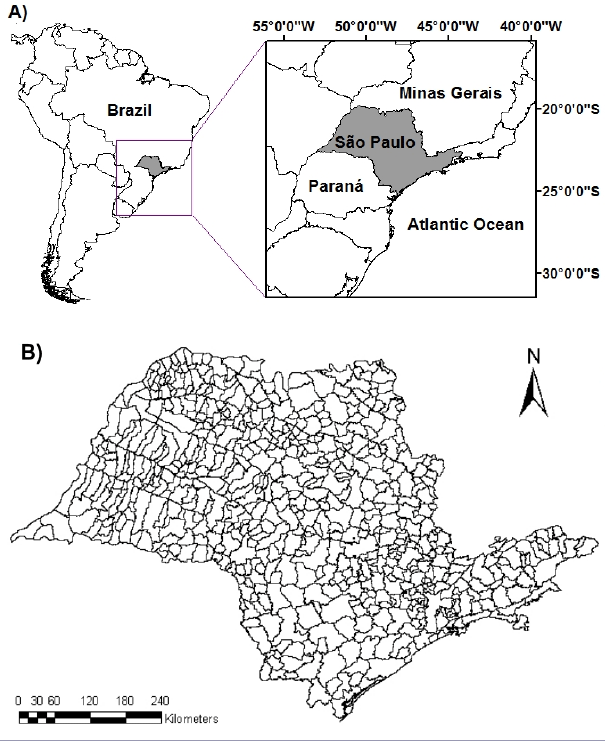
Fig. 1 . The state of São Paulo, Brazil (A), and the 645 municipalities analyzed in this study